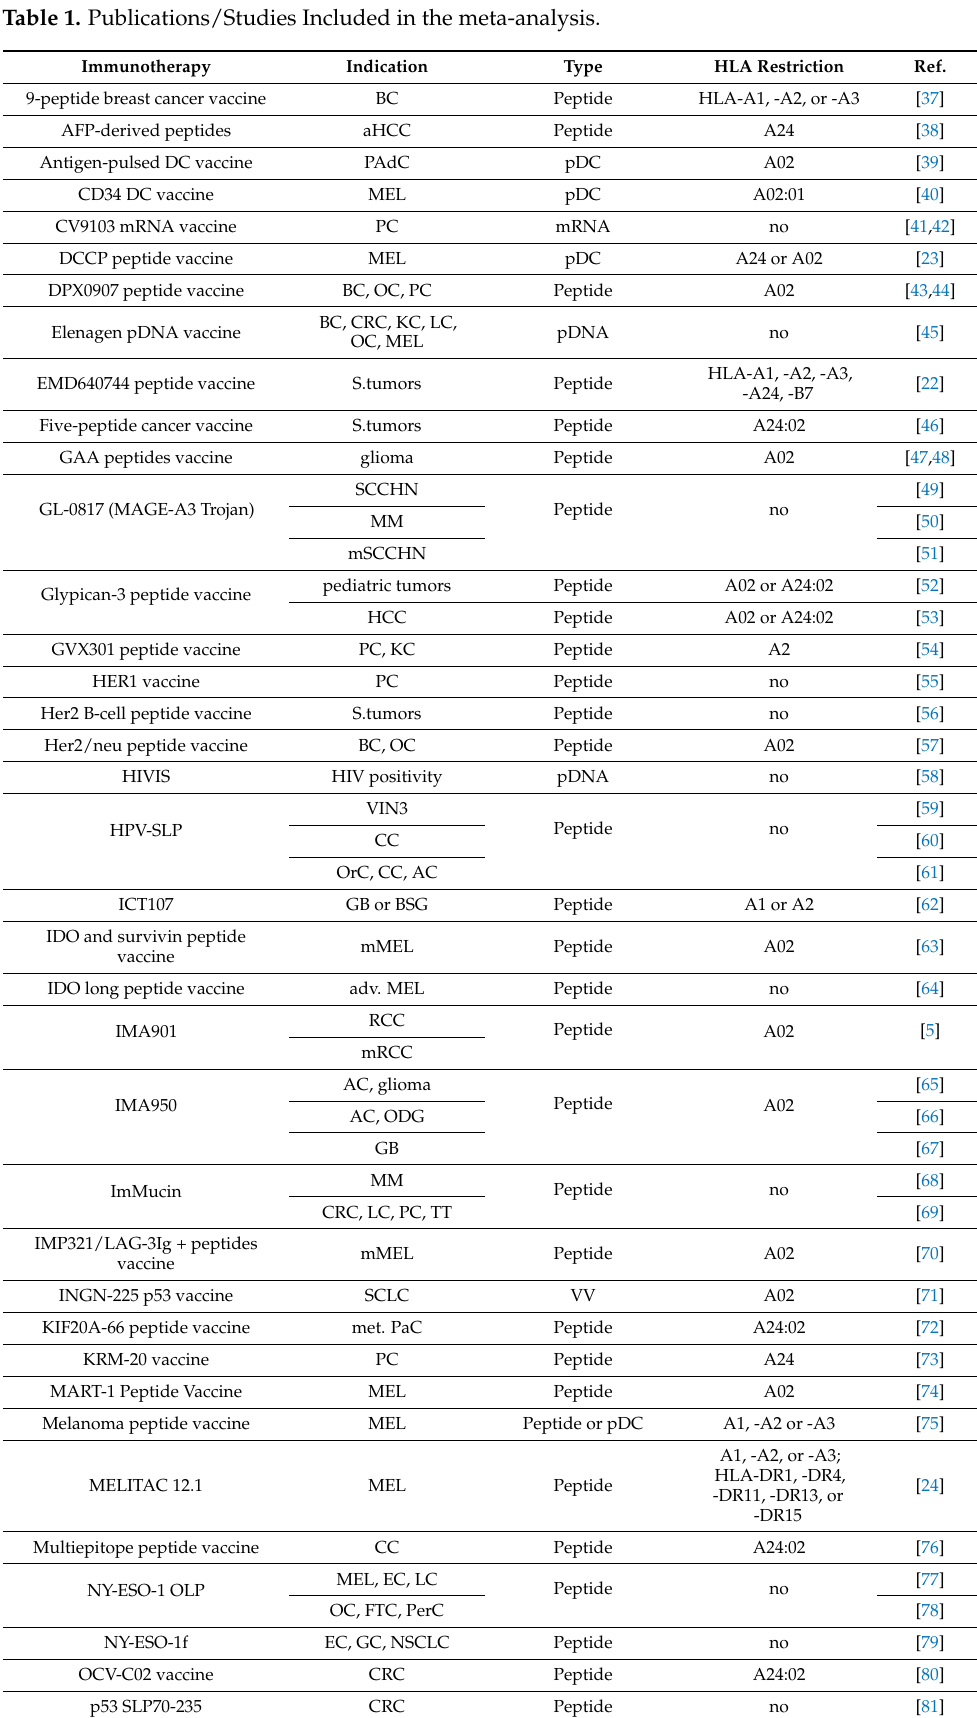
Table 1. Publications/Studies Included in the